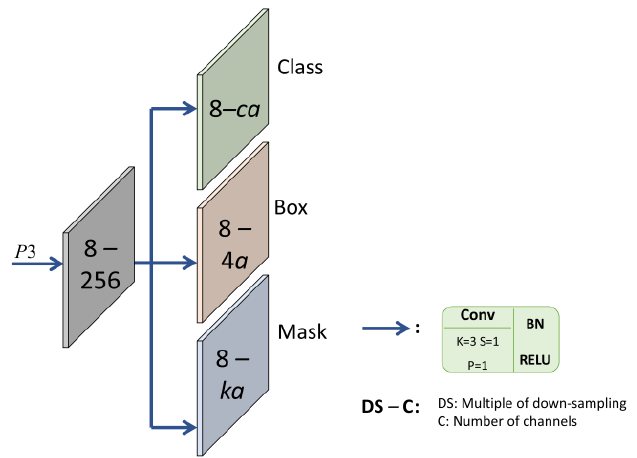
Figure 6. Prediction head in Key-Yolact.